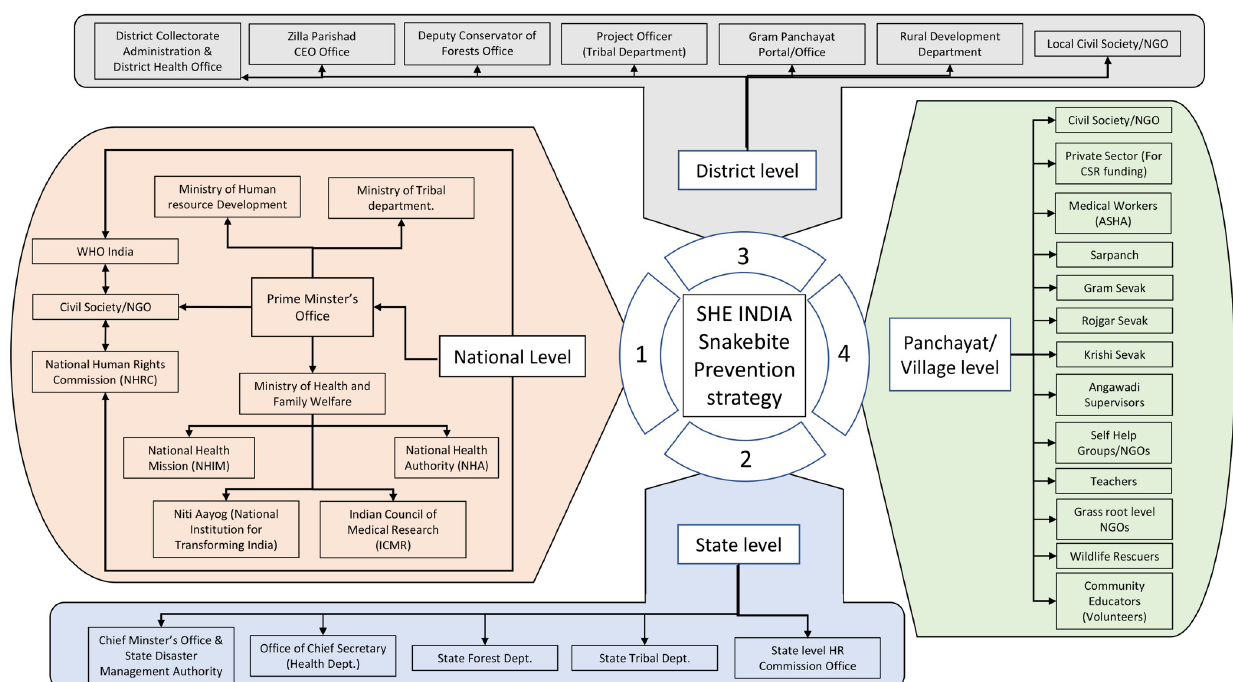
Fig 1. Flow chart outlining SHE-India’s working model for engagement of key stakeholders at different levels. Zilla Parishad = District level council. Sarpanch = Village head. Gram Sevak = community welfare advisor. Gram Panchayat = village/town council. Rojgar Sevak = Village council employees. Krishi Sevak = Agricultural advisor. Angawadi supervisors = Supervisor of Preschool ( < 5 y) educators.